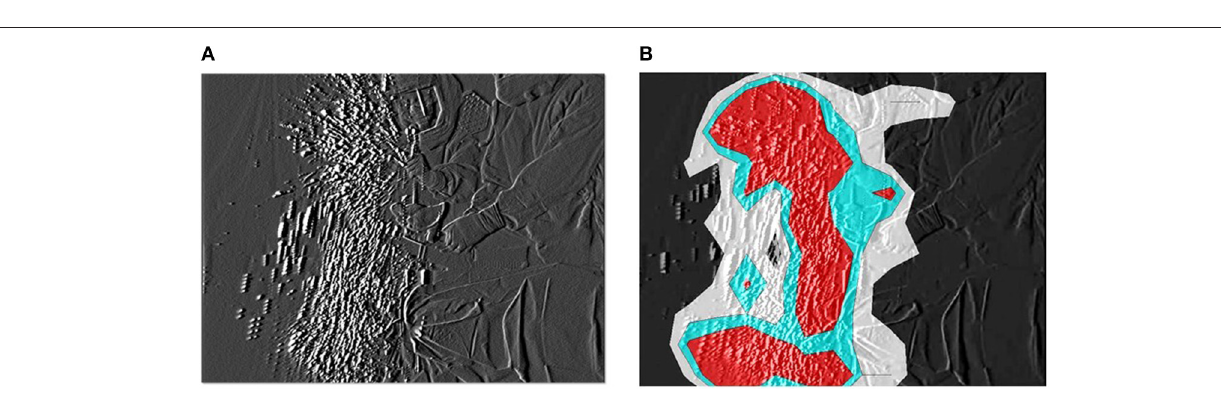
FIGURE 2 | Hammering the trial shell to the acetabulum. (A) The generated particles are widely dispersed and carried higher from the acetabulum and drop down to the floor. (B) The particle density hazard map displays risk areas expanding in all directions over a 3-m